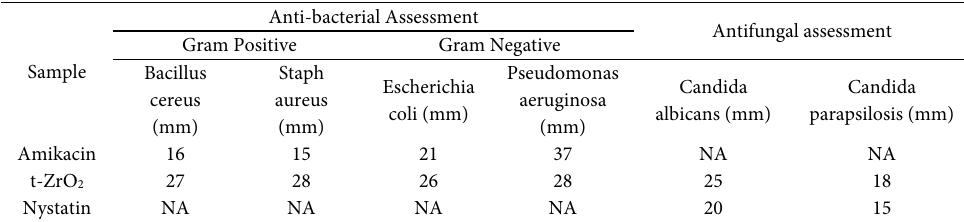
Table 2. Anti-bacterial and Anti-fungal assessment of